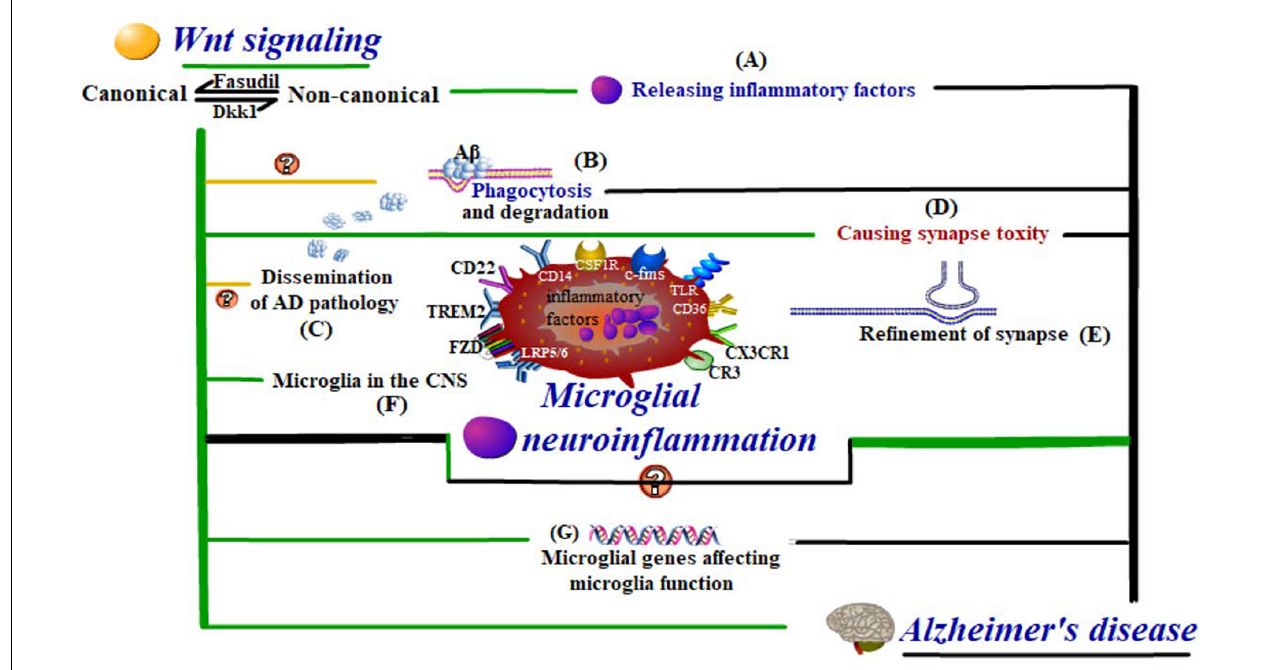
FIGURE 3 | Wnt-regulated microglial neuroinflammation in Alzheimer’s disease. Wnt regulation influences the cell fate and activities of (F) microglia in the CNS, even at the level of (G) microglial genes affecting microglial functions. These functions include (A) inflammatory response, (B) A β phagocytosis and degradation, (C) dissemination of AD pathology, and (D,E) synapse modification, which are all closely related to neuroinflammation in AD